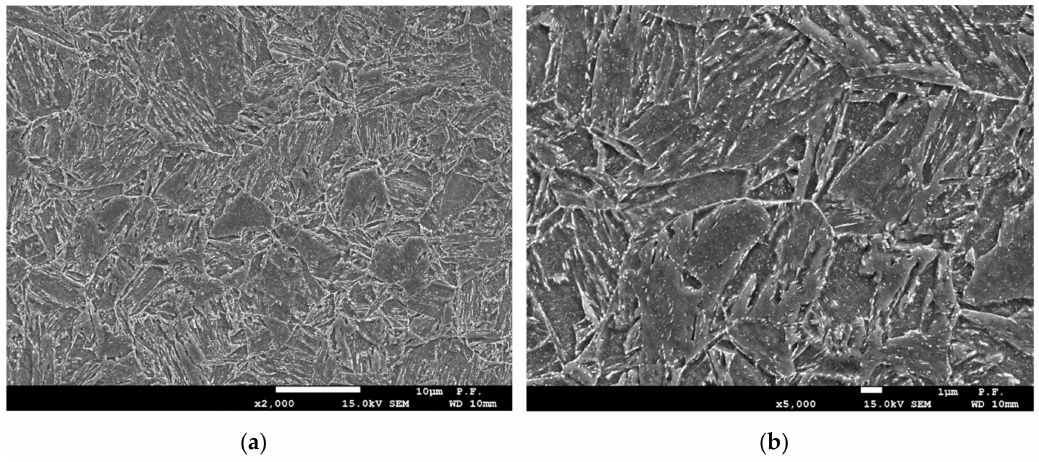
Figure 1. Microstructure of the base material, AHSS S960QC: ( a )—2000 × ; ( b )—5000 ×